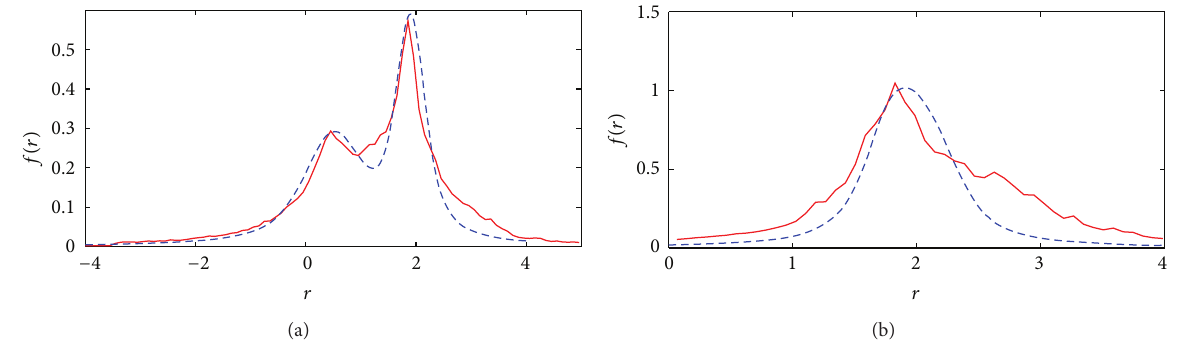
Figure 10: (a) and (b) The theoretical (dashed) distributions of residuals for Figure